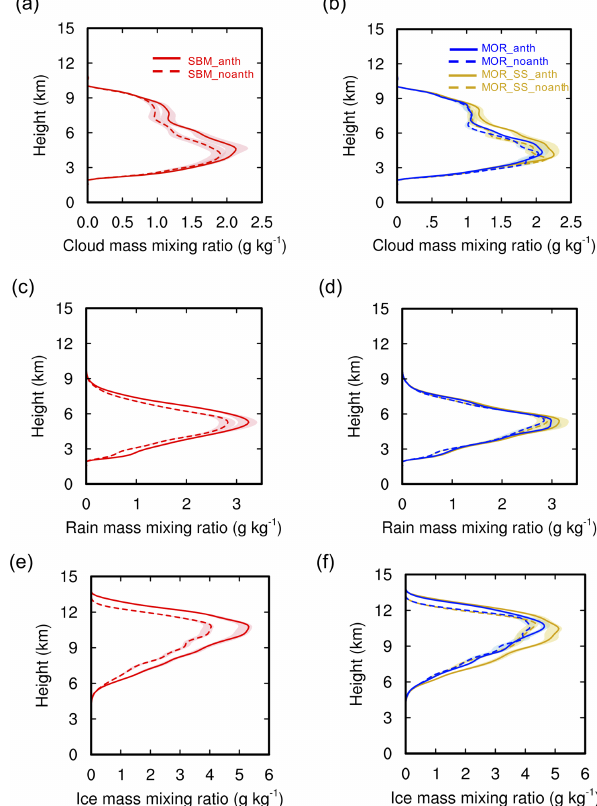
Figure 14. Vertical profiles of (a, b) cloud droplet, (c, d) raindrop, and (e, f) ice particle (including ice, snow, and graupel) mass mixing ratios (unit: gkg − 1 ) averaged over the top 25 percentiles (i.e., from the 75th to the 100th percentile) of the updrafts with a value greater than 2ms − 1 from the simulations SBM_anth and SBM_noanth (red), MOR_anth and MOR_noanth (blue), and MOR_SS_anth and MOR_SS_noanth (orange) over the study area (red box in Fig. 7) during the strong convection period (20:00–23:00UTC on 19 June 2013). Data are processed in the same way as for Fig.